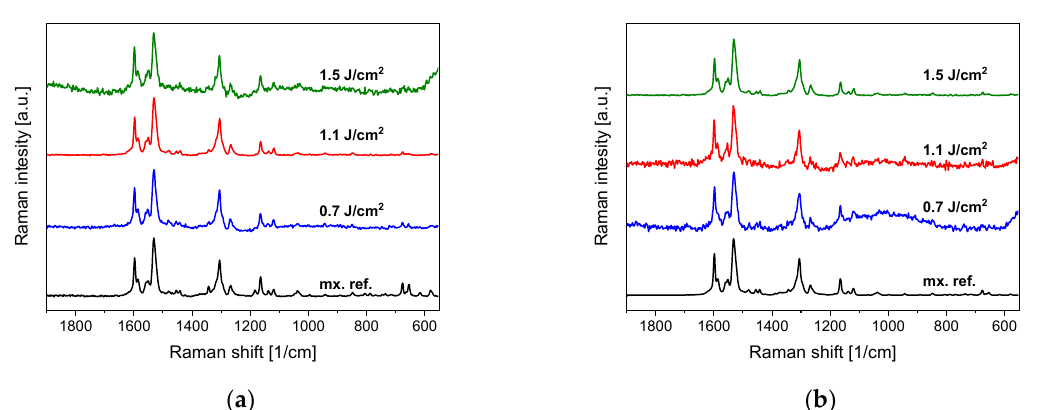
Figure 4. ( a ) Raman spectra of PLA-generated particles and the original meloxicam (mx. ref.) powder as reference. ( b ) Raman spectra of PLAL-generated particles and the original meloxicam (mx. ref.) powder as reference. The Raman spectra were normalized in both cases to the peak at around 1530 cm − 1 .